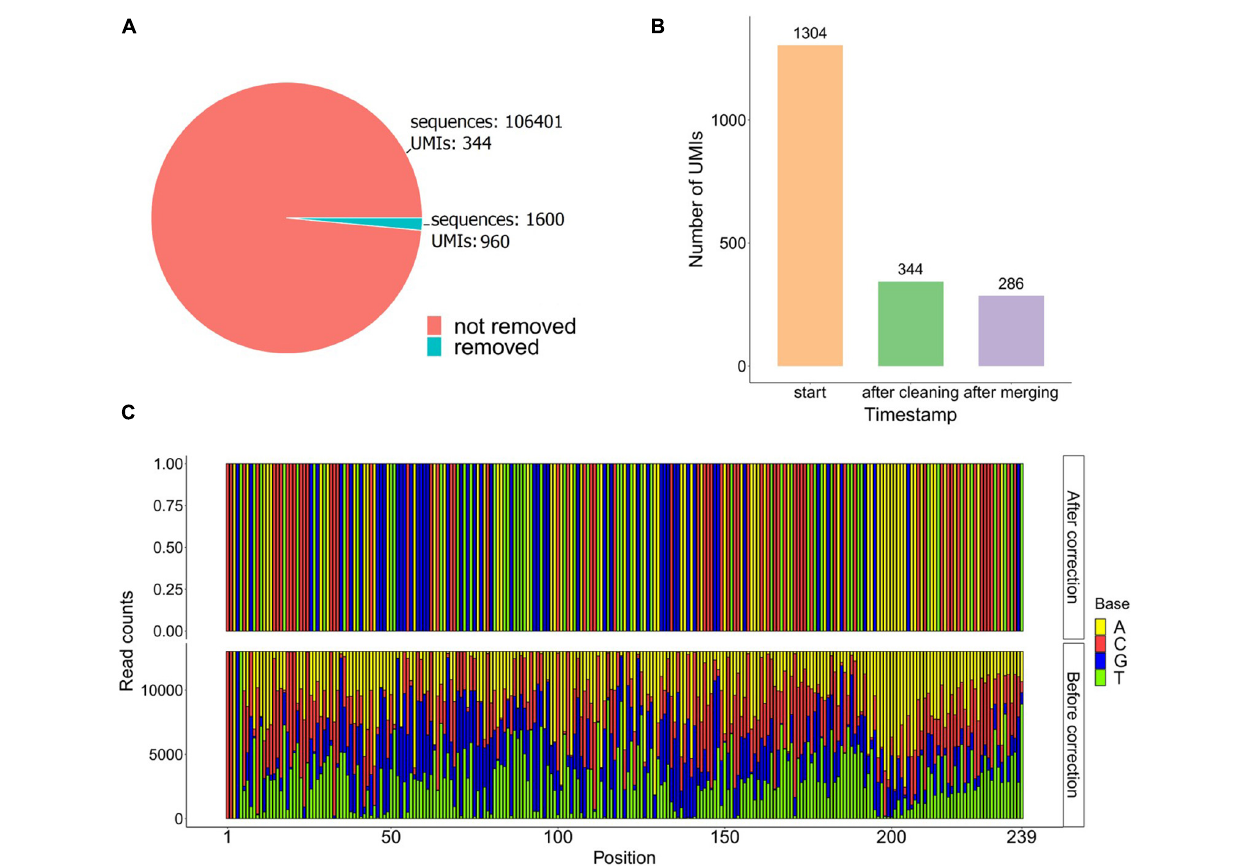
FIGURE 5 | (A) Pie chart of the sequences before and after the data-cleaning step. (B) Bar plot of the UMIs found on the raw fastq file (start) and the UMIs remaining after the cleaning and the merging steps. (C) Frequency bar plot of the bases from 13,020 reads in each position using the UMI GTAAAACGACGG after and before